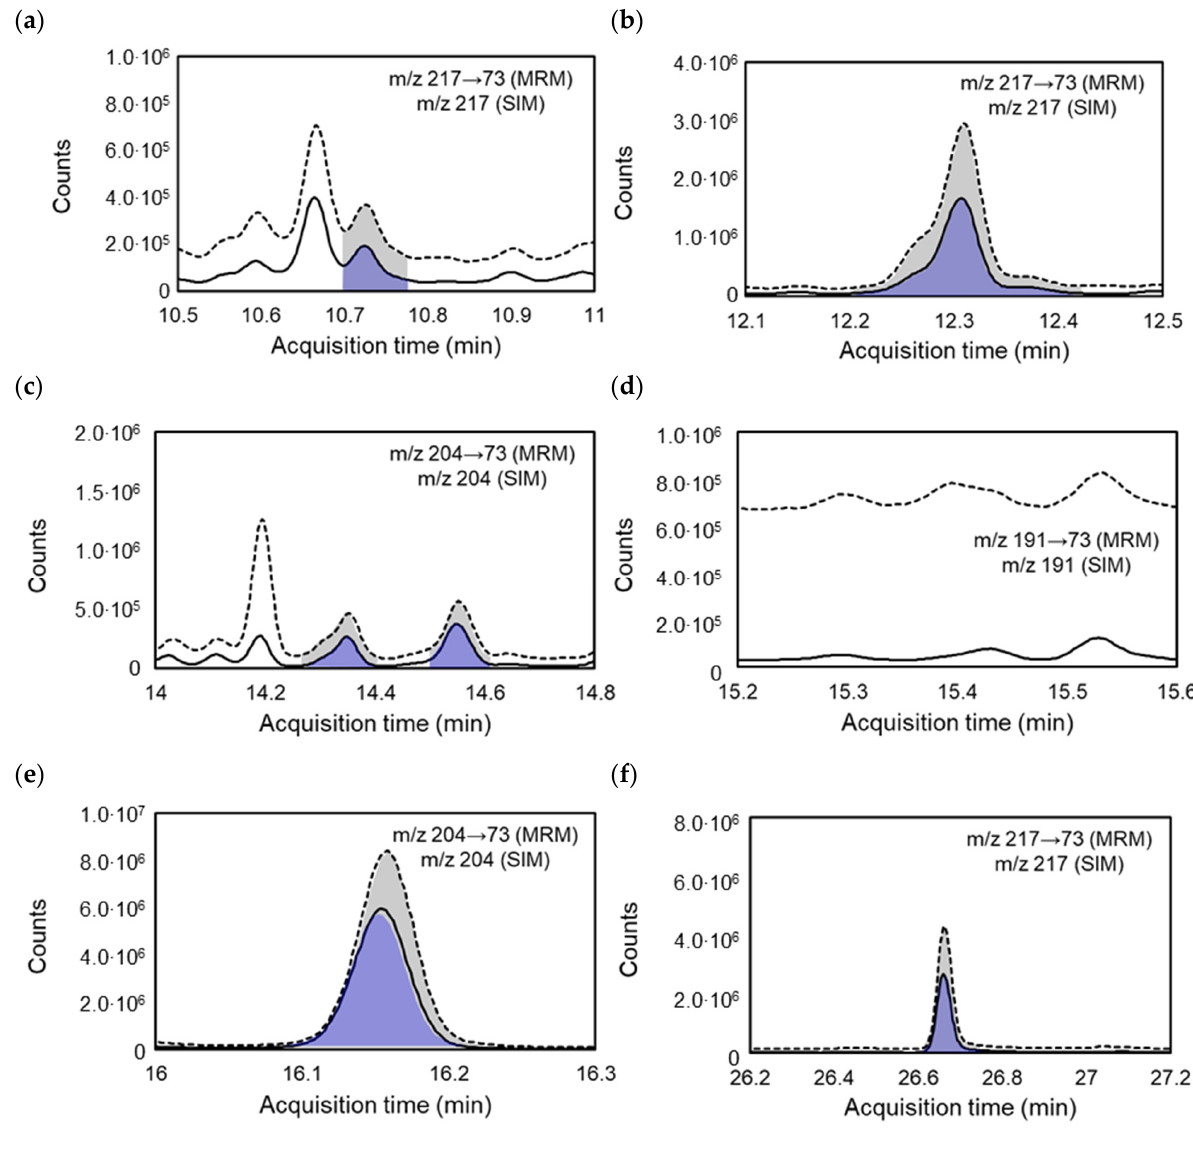
Figure 2. Product ion spectra of derivatized ( a ) arabinose (precursor ion: m/z 217), ( b ) levogluco- san (precursor ion: m / z 204), and ( c ) xylose (precursor ion: m / z 191).